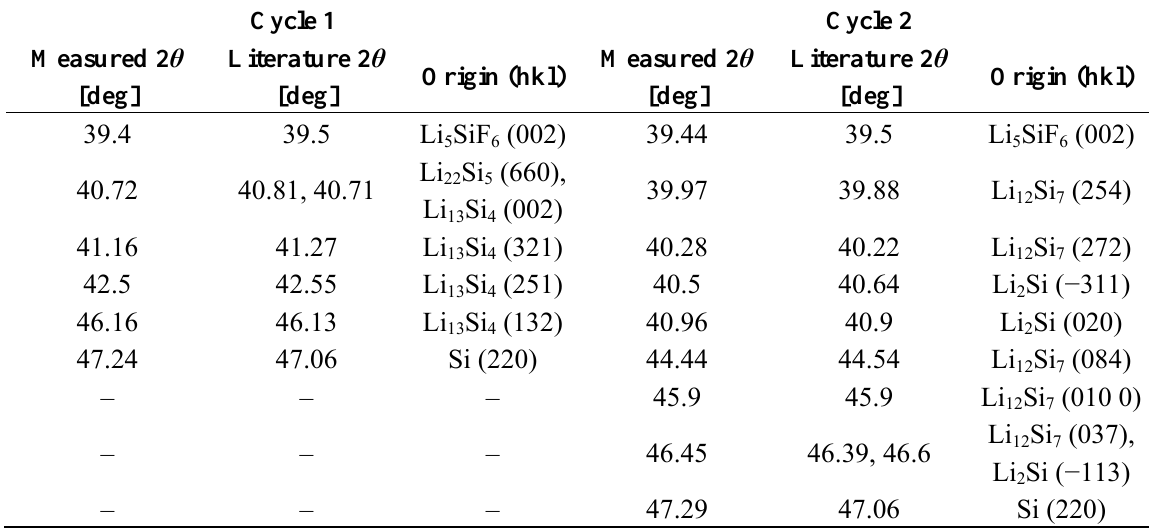
Table 1. X-Ray Diffraction (XRD) peaks from lithiated Si microwire anodes after the first and second charging